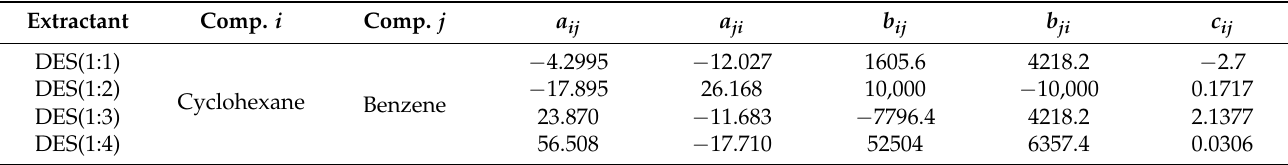
Table 8. Estimated values for the binary parameters using the NRTL model for correlating the pseudo-binary VLE data at a constant DES molar fraction of 0.1 within a pressure of 101.325 kPa.